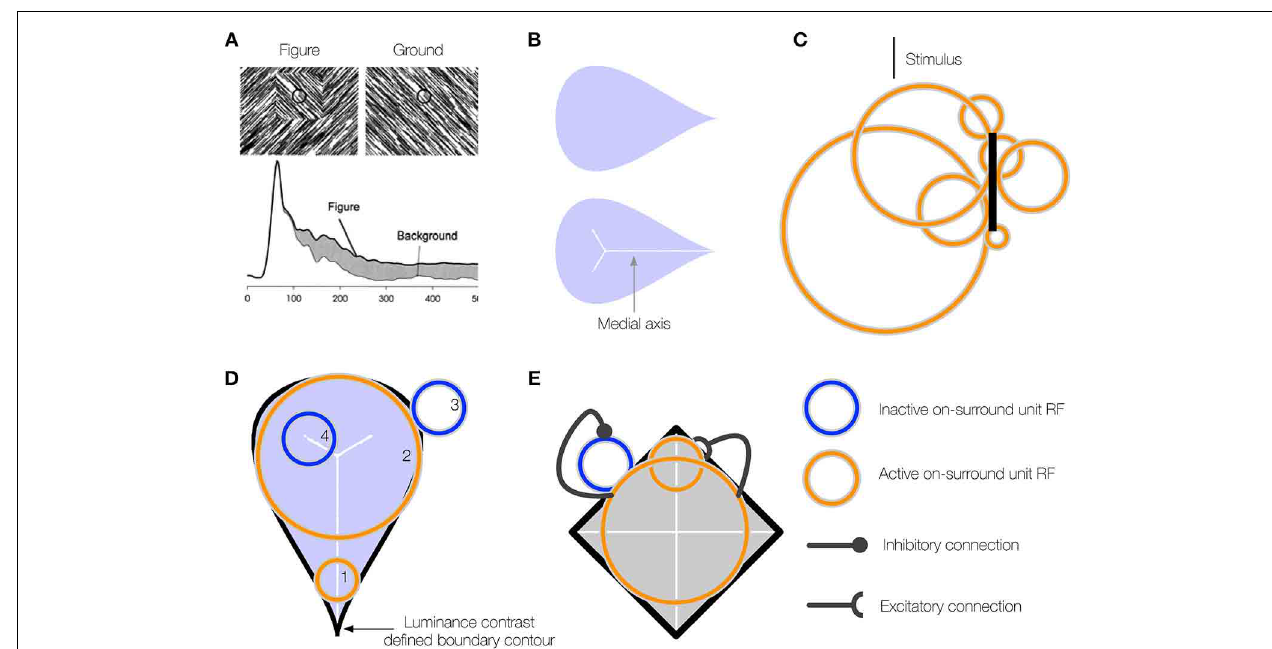
medial axis of a figure. Units 1–2 respond strongly when their on-surround, annulus-shaped RFs are centered on certain points along the medial axis of the teardrop figure. The response is driven by contact between the annulus and the boundary contours, defined by luminance contrast (black). The response is weak when the RF is not centered along the medial axis (3) or the RF size of a unit centered along the medial axis is too small (4) or large compared to the boundary. (E) On-surround units may falsely respond outside of a figure due to the presence of a boundary contour in the RF (blue). Feedback from units with large RFs, which provide a measure of the closure of the figure boundary, can enhance the activity of units whose RFs are centered on the interior of a figure (orange) and suppress due to the background